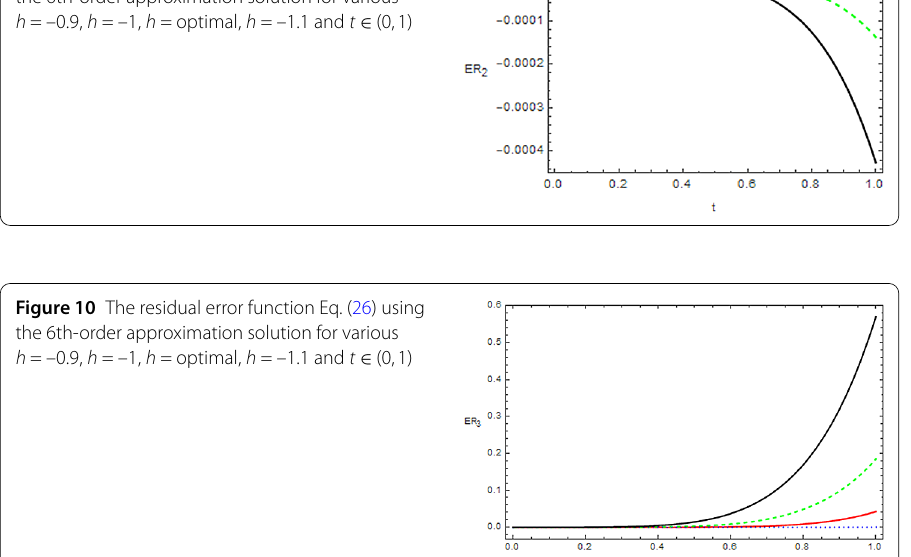
Figure 9 The residual error function Eq. (25) using the 6th-order approximation solution for various h = –0.9, h = –1, h = optimal, h = –1.1 and t ∈ (0,1)